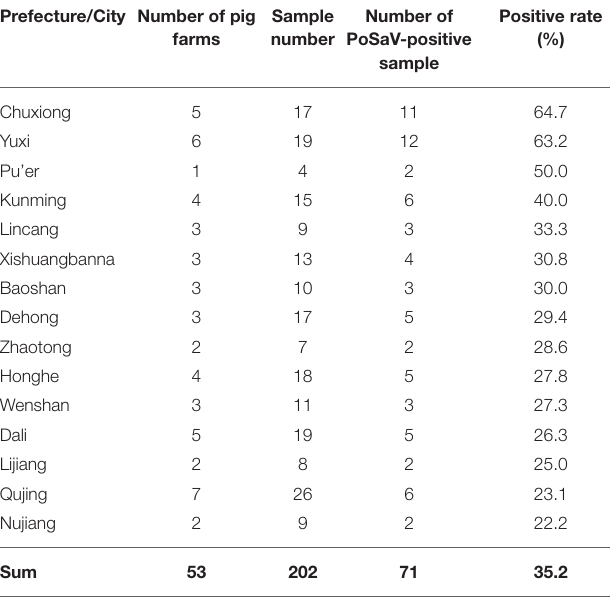
TABLE 1 | Sample collection and detection rate of porcine